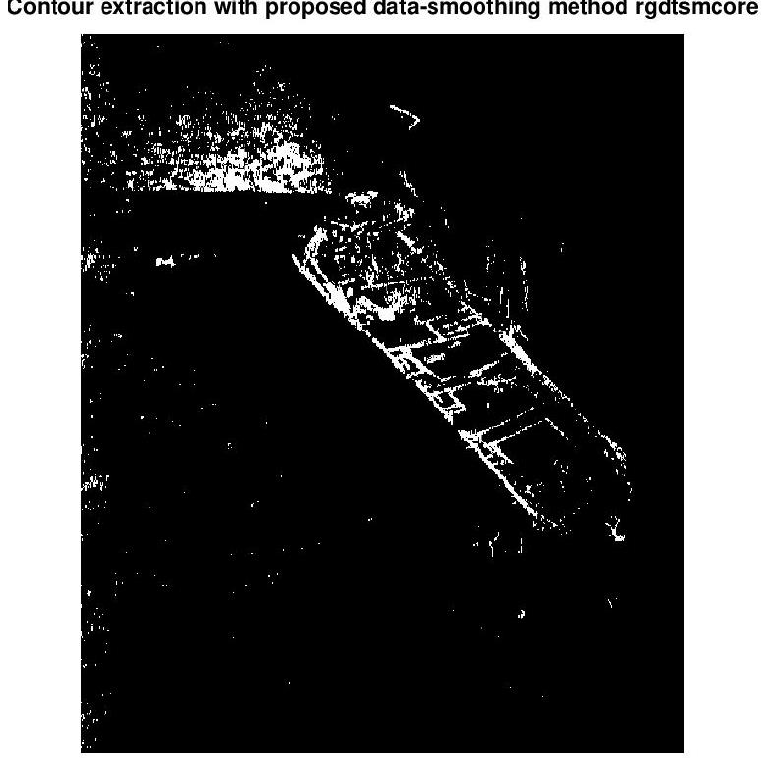
Figure 19. Data-smoothing achieved by